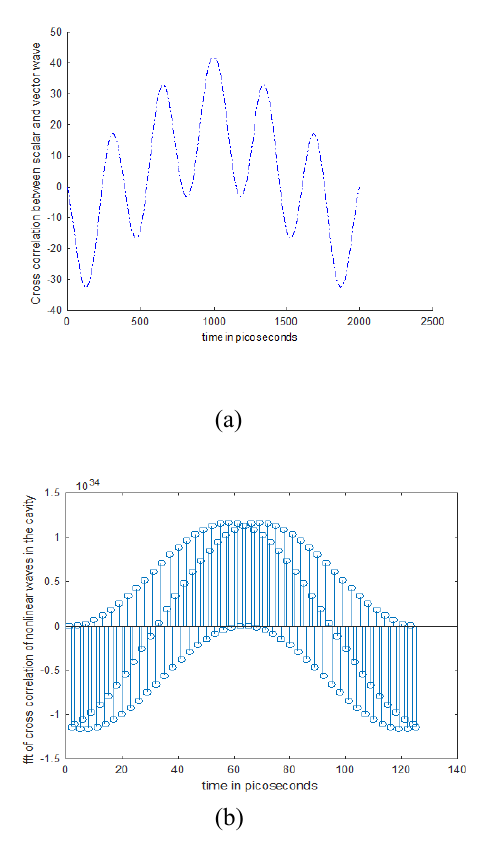
Figure 7: (a) Correlation between scalar and vector wave components, (b) FFT plot of the